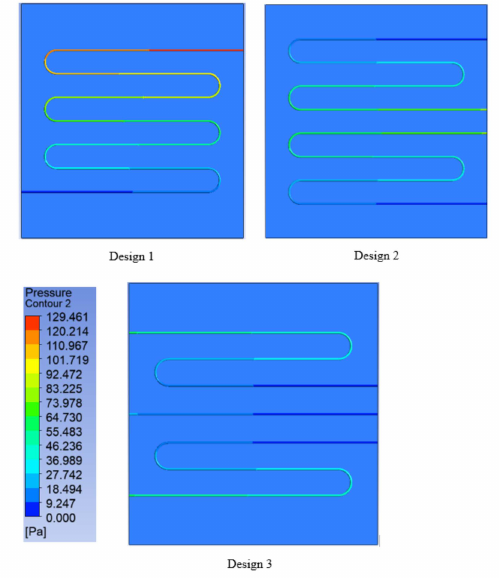
Figure 10. Pressure contours for the three different flow